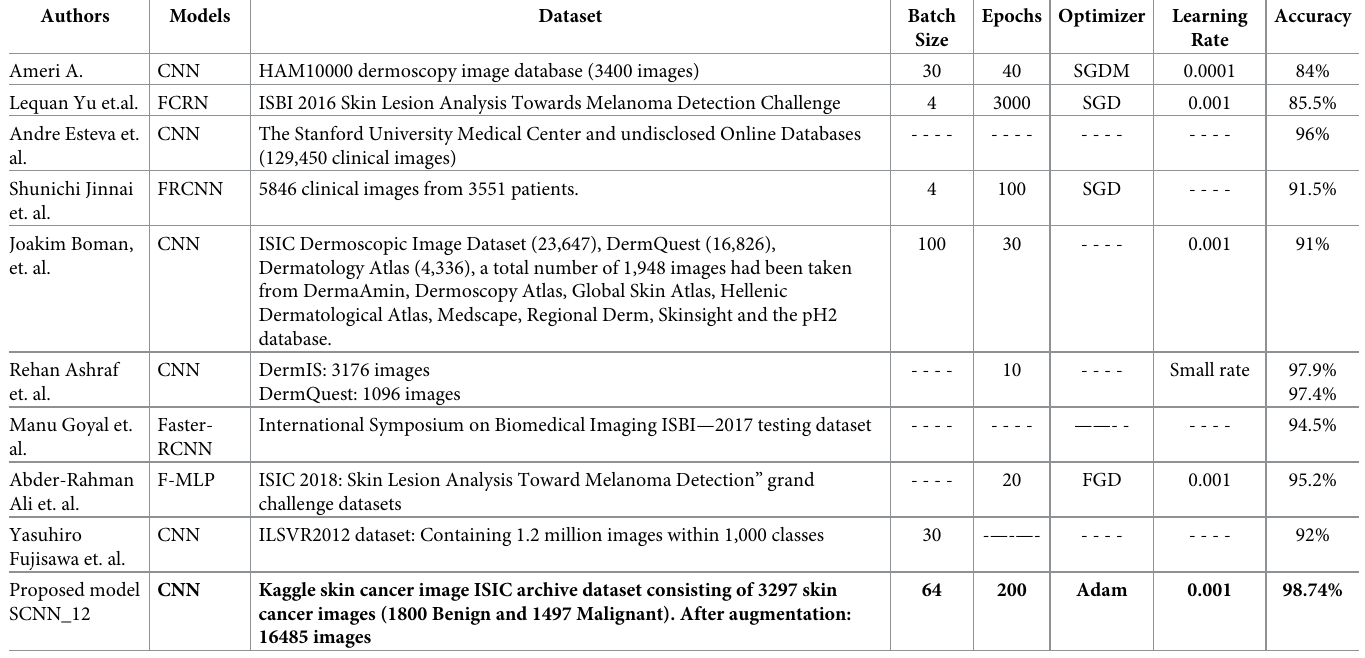
Table 24. Comparison of accuracy between the proposed system and existing